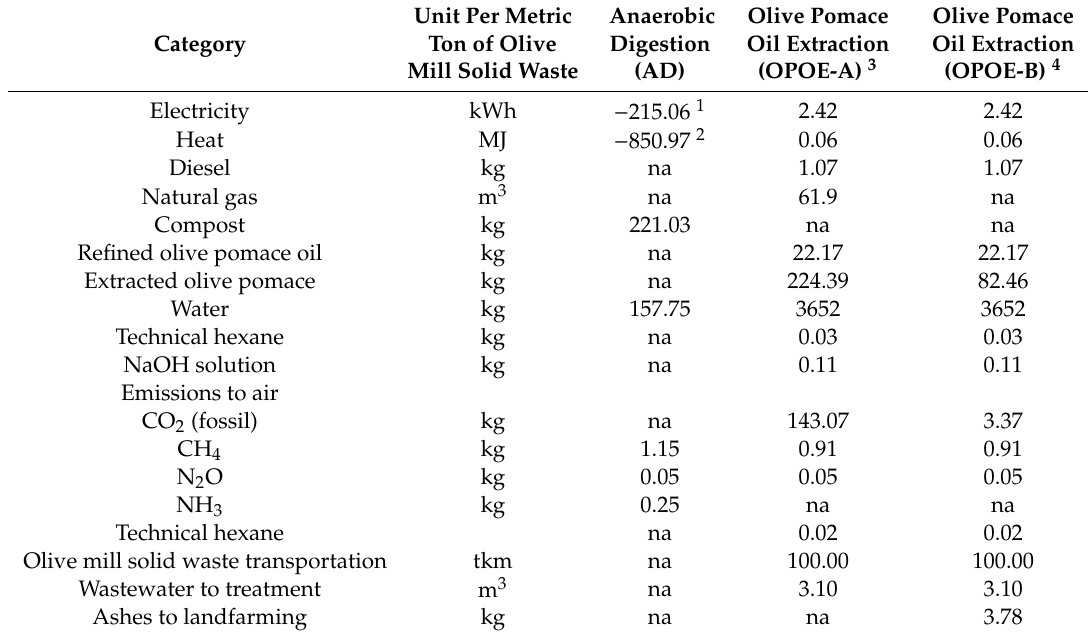
Table 2. Inventory data referred to 1 metric ton of olive mill solid waste. na; not